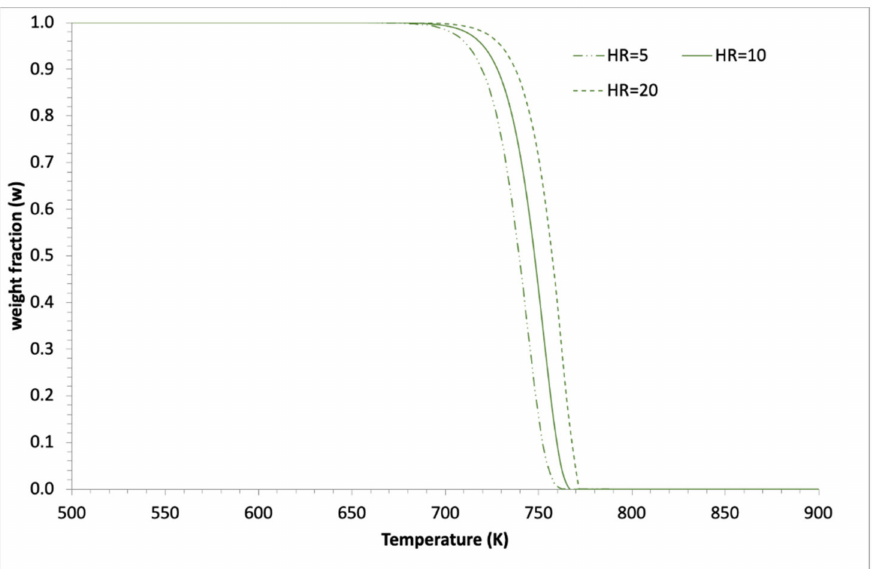
Figure 4. Effect of the heating rate (HR) on the decomposition curve’s position without varying the kinetic constants. In this case, the curve does NOT move appreciably to the right when the HR increases (in K/min, indicated in the